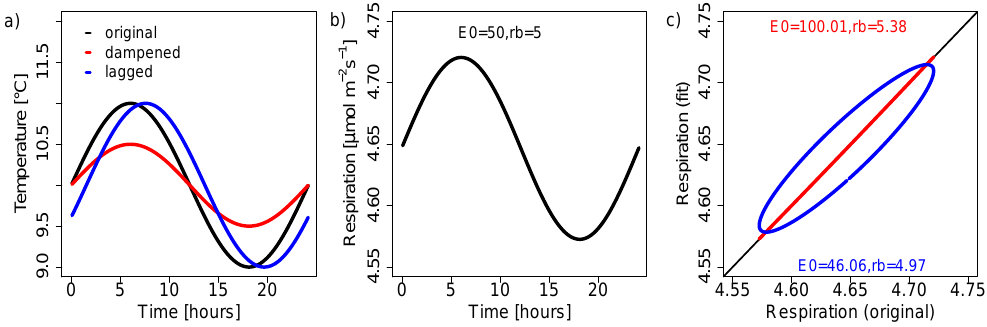
Fig. 1. Illustration of the potential effects of using temperatures that are lagged or dampened on the fit with the respiration model. (a) Artificial temperature time series, (b) respiration model output [µmolCm − 2 s − 1 ] with original (see a ) temperature time series and parameter values used, and (c) model output of (b) versus the respiration model outputs optimised for the model output of (b) using the lagged and dampened time series of (a) and optimised parameter values.